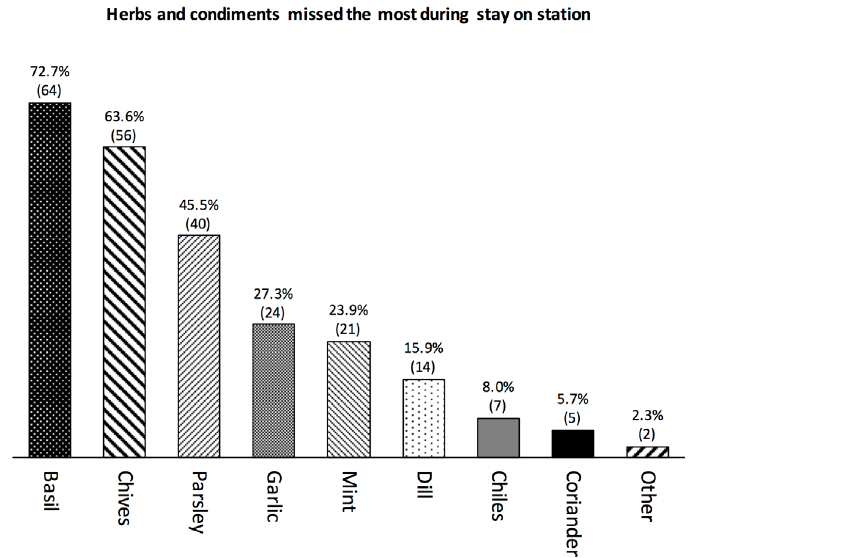
Figure 6: The 85% of respondents indicating that the availability of fresh fruit, vegetables and herbs grown on the Neumayer Station (85%, 88 individuals) would improve their overall well-being were asked to choose up to three from the crops listed in the category ‘Herbs/condi- ments’ or to make their own suggestions. The presented data consists of a total of 233 answers.